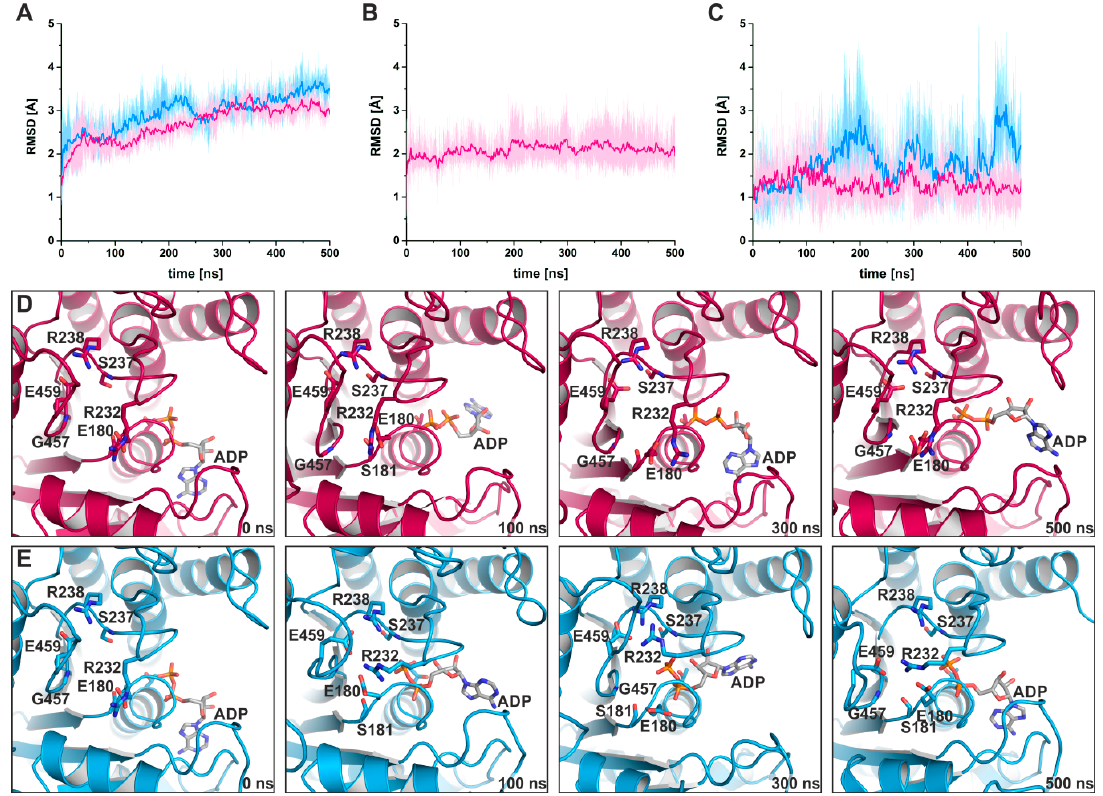
Figure 6. Classical molecular dynamics (cMD) simulations support the stabilizing effect of blebbistatin on the crystallographically determined conformation of myosin-II. ( A ) Root mean square deviations of the protein backbone atoms, averaged over duplicate 500 ns cMD simulations of blebbistatin-bound (magenta) and -unbound (blue) myosin, confirm the stabilizing effect of blebbistatin on the crystallized conformation, while in the absence of blebbistatin, larger deviations from the start structure were observed. ( B ) Blebbistatin remains embedded in its binding pocket throughout the simulations, showing only negligible deviations from its crystallized binding pose. ( C ) Root mean square deviations of the converter indicate no movement of the converter while blebbistatin is bound (magenta); however, a smaller shift towards the pre-power stroke position of the converter is monitored in the absence of blebbistatin (blue). Shown in diagrams A-C are the averages of duplicate cMD simulations. ( D ) The positions of active site phosphate sensors are stabilized spatiotemporally along the cMD simulations in the presence of blebbistatin, with the critical salt-bridge formed. Binding of ADP in the crystallized conformation appeared loose during the cMD simulations with considerable fluctuations of the nucleotide. ( E ) During cMD simulations in the absence of blebbistatin, the P-loop moved towards switch-1 and -2 in the reversed direction of the power stroke. The nucleotide ADP was markedly shifted together with the P-loop inside into the active site.